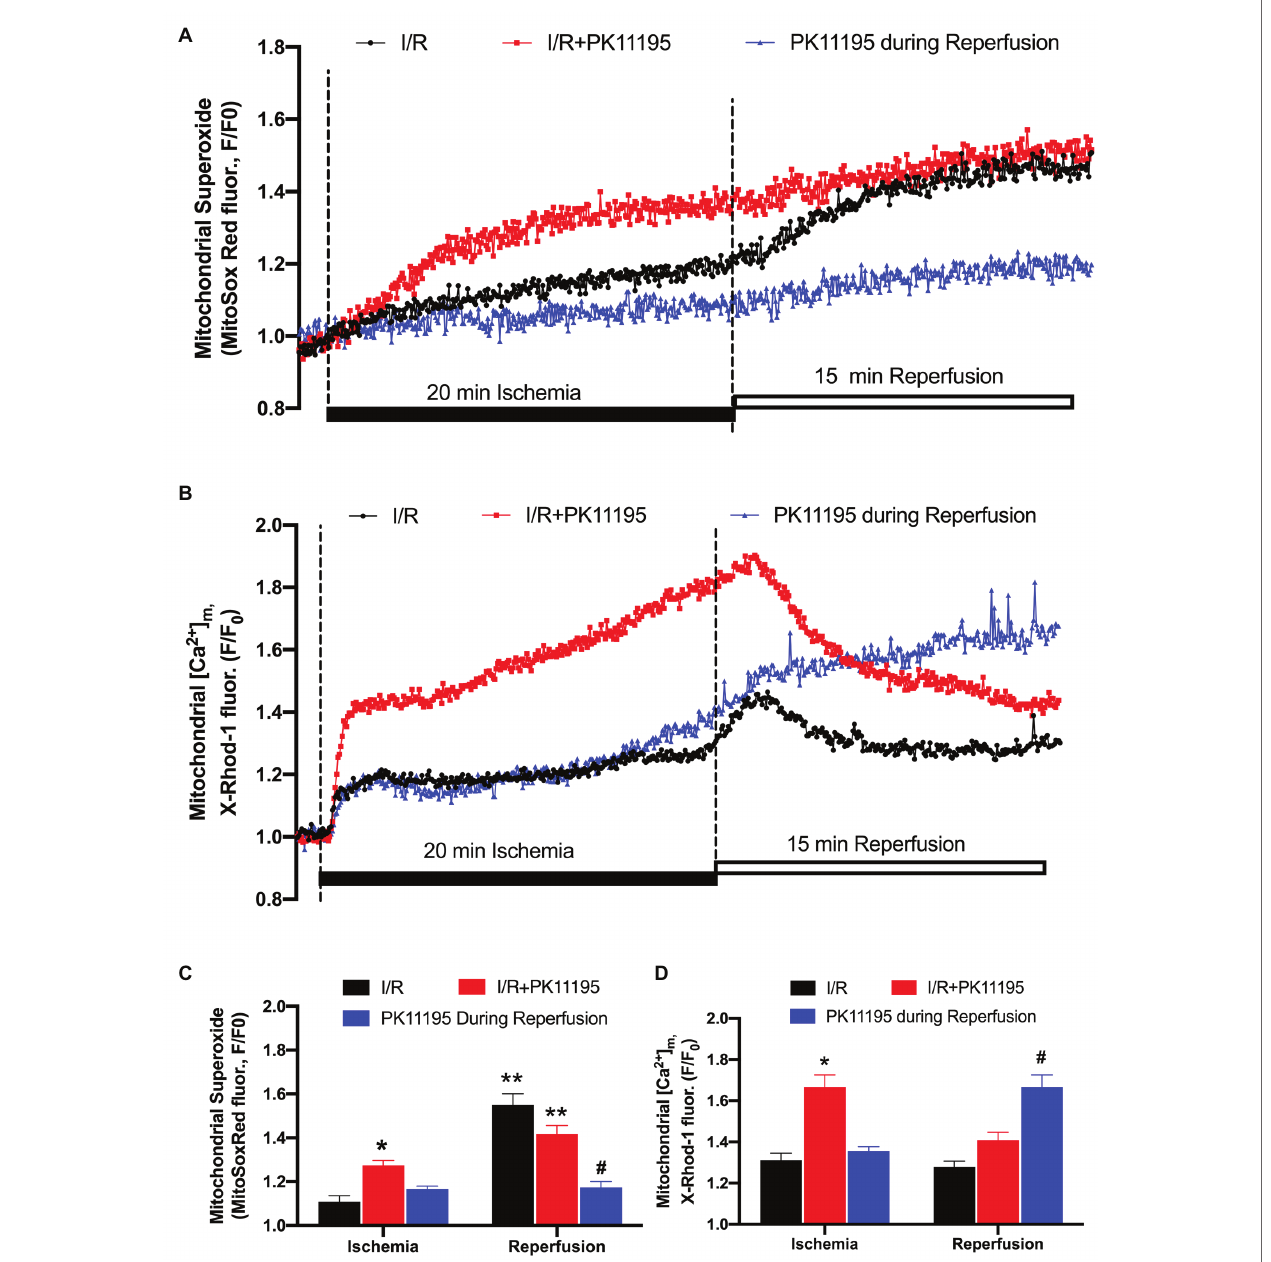
FIGURE 4 | Changes in reactive oxygen species (ROS) generation and mitochondrial Ca 2+ concentration during simulated ischemia and reperfusion. (A) Representative traces of superoxide generation measured with MitoSox Red during I/R in the absence of 50 μ M PK11195 (black) and when 50 μ M PK11195 was added during the whole period of I/R (red) or added during a reperfusion phase (blue). (B) Changes in mitochondrial Ca 2+ measured with X-Rhod-1 during I/R in the absence of 50 μ M PK11195 (black) and when 50 μ M PK11195 was added during the whole period of I/R (red) or added during a reperfusion phase (blue). (C,D) Effects of PK11195 on mitochondrial ROS and [Ca 2+ ] m during I/R when added during I/R (red) or at the onset of reperfusion (blue). Data expressed as mean ± SEM. n = 3–5 animals per group. * p < 0.05 reflects a difference between untreated I/R cardiomyocytes and cardiomyocytes which were treated with 50 μ M PK11195 during I/R; # p < 0.05 reflects a difference between untreated I/R cardiomyocytes and cardiomyocytes which were treated with 50 μ M PK11195 at the onset of reperfusion; ** p < 0.05 reflects the difference between the corresponding ischemia and reperfusion